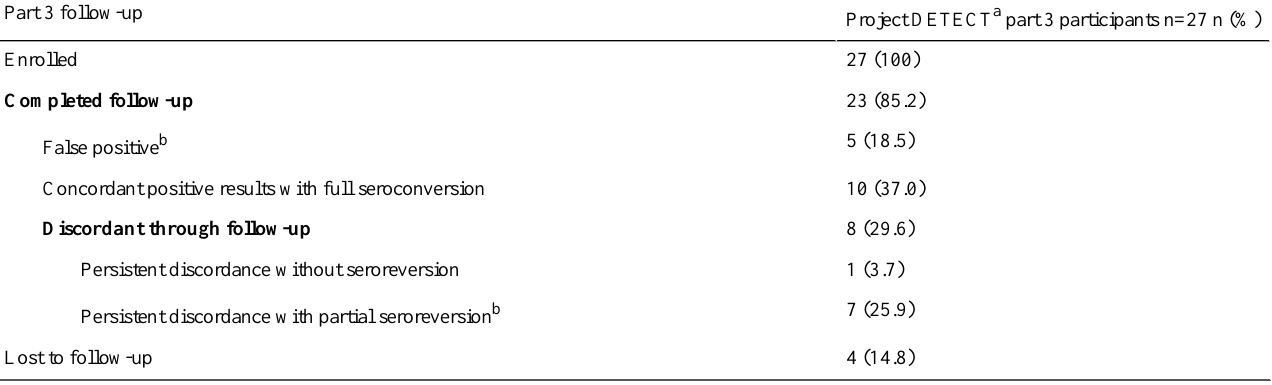
Table 4. Project DETECT part 3 enrollment and follow-up (September 2015 to March